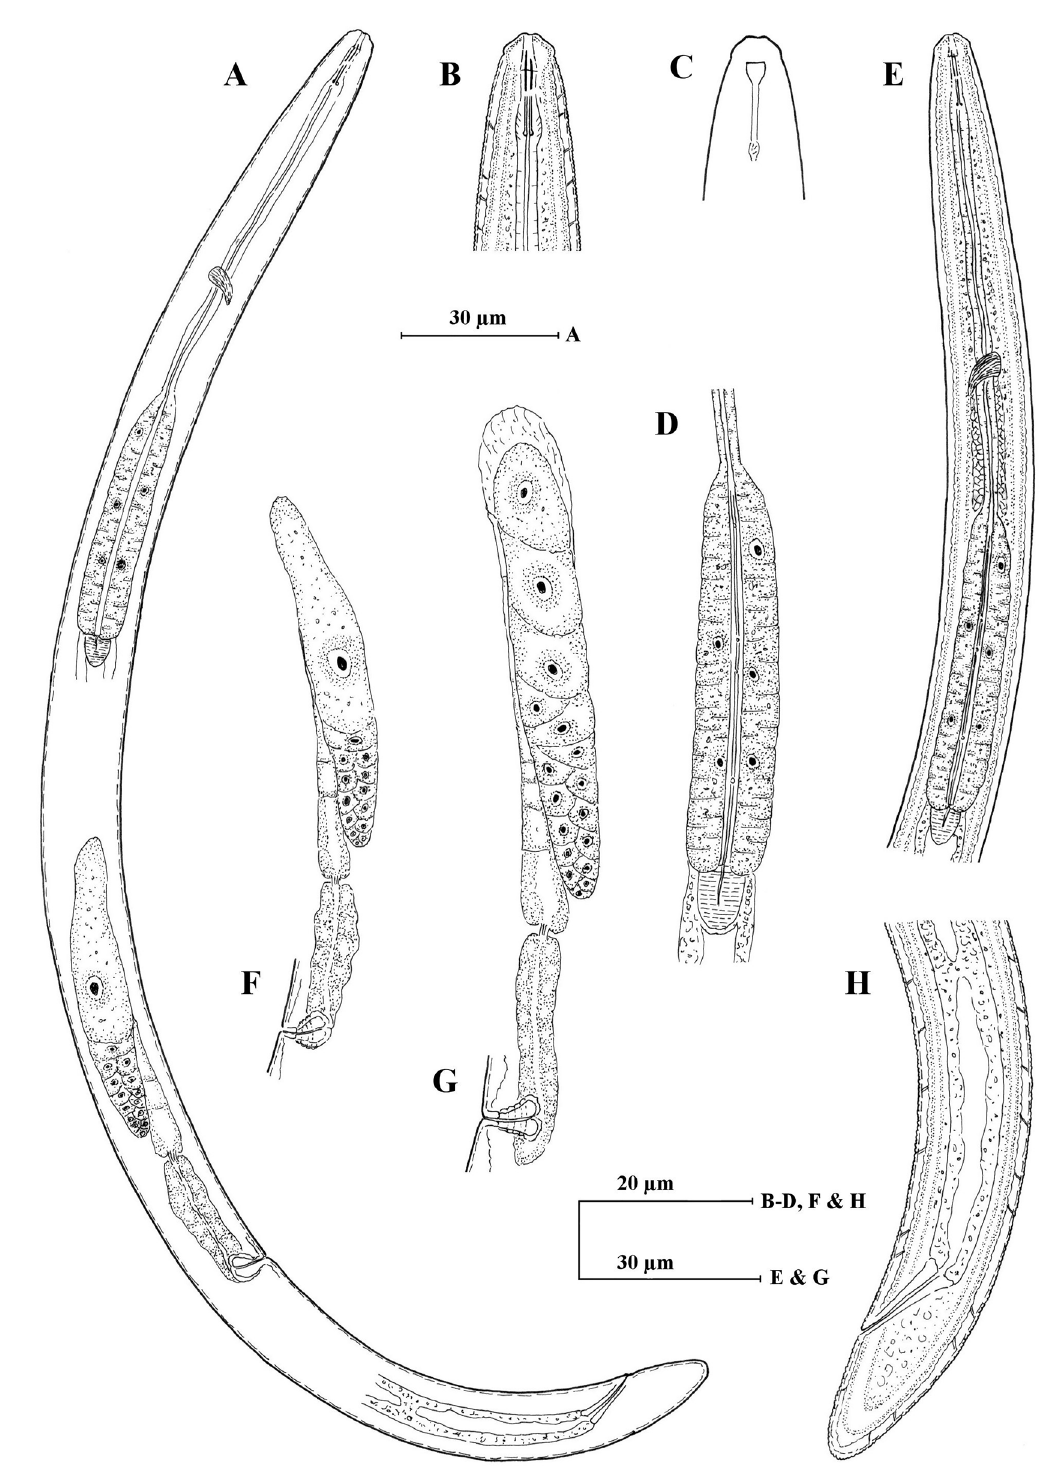
Fig. 13. Tylencholaimus striatus sp. nov., ♀. A, D–F, H . Paratype 1 (slide 2). B–C . Holotype (AMU/ ZD/NC/ Tylencholaimus striatus /1). G . Paratype 5 (slide 4). A . Entire specimen. B . Anterior region C . Anterior region showing amphid. D . Expanded part of pharynx. E . Pharyngeal region. F–G . Genital system. H . Posterior